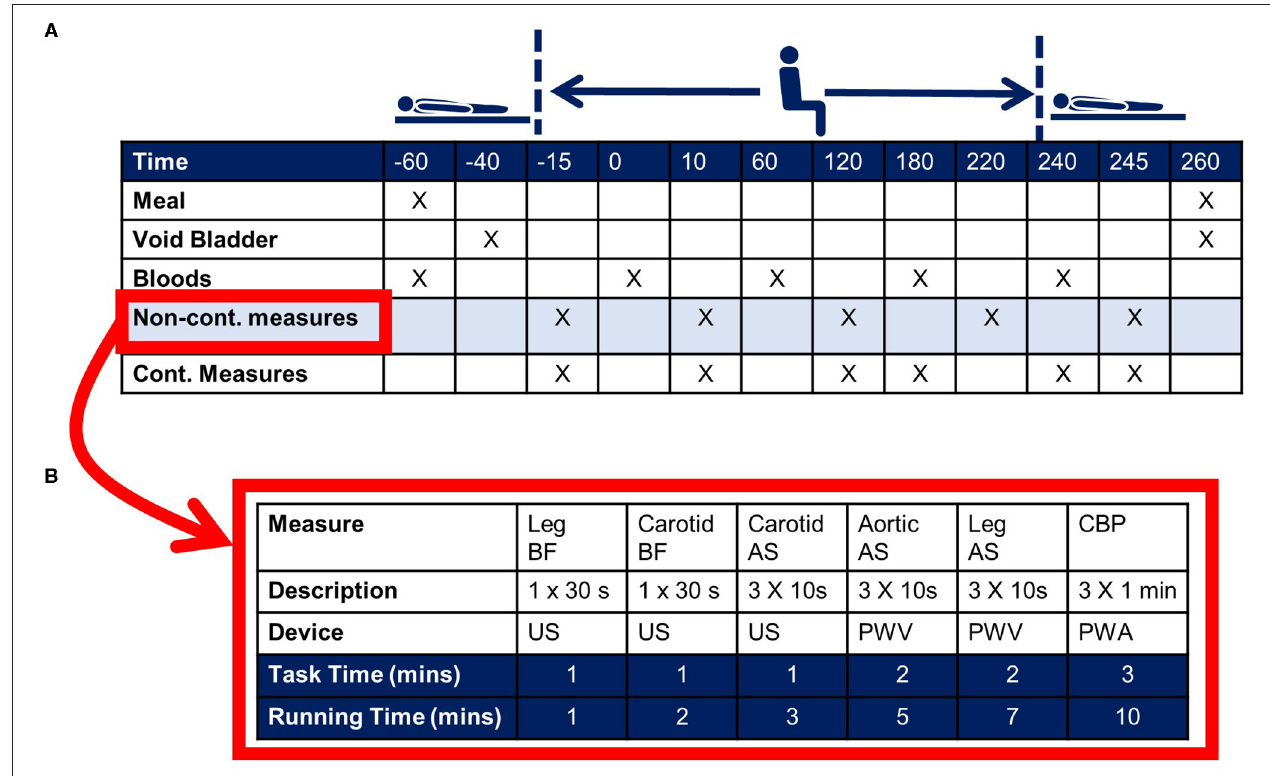
FIGURE 6 | Example experimental protocol for an acute sitting study. (A) Indicates the time for a 3-h sitting study. Upon arrival to the laboratory the subject consumes a standard small meal/snack and venous blood is collected. The subject then rests quietly in the supine posture for 20-min prior to passive transfer to the seated posture. At the end of the 3-h sitting bout the subject is transferred back to the supine posture. Primary outcomes are collected in the supine posture. The cross marks indicate the measurement timepoints. (B) Indicates example non-continuous outcomes, including ultrasound (US)-derived leg blood flow (BF) and